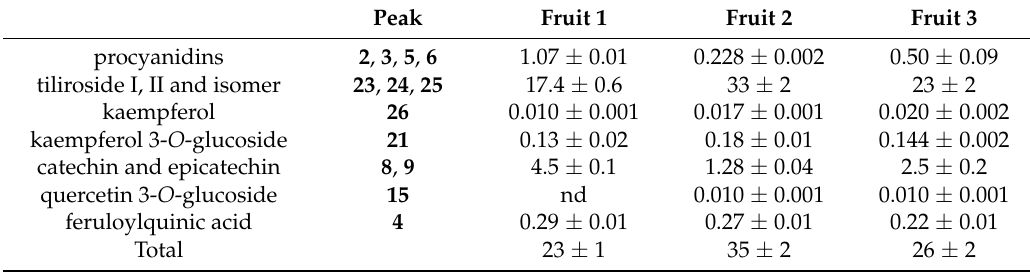
Table 3. Quantitative amount ( µ g/g ± standard deviation of dried fruit pulp) of phenol constituents detected in baobab fruit pulp. Compound numbers (in bold) correspond with peak numbers in Figure 4. Peak Fruit 1 Fruit 2 Fruit 3